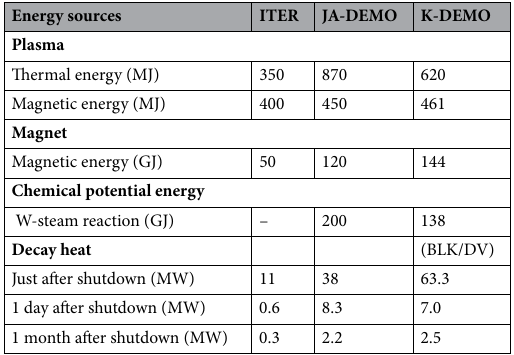
Table 3. Tentative assessment results of energy sources in K-DEMO and a comparison to those in ITER and